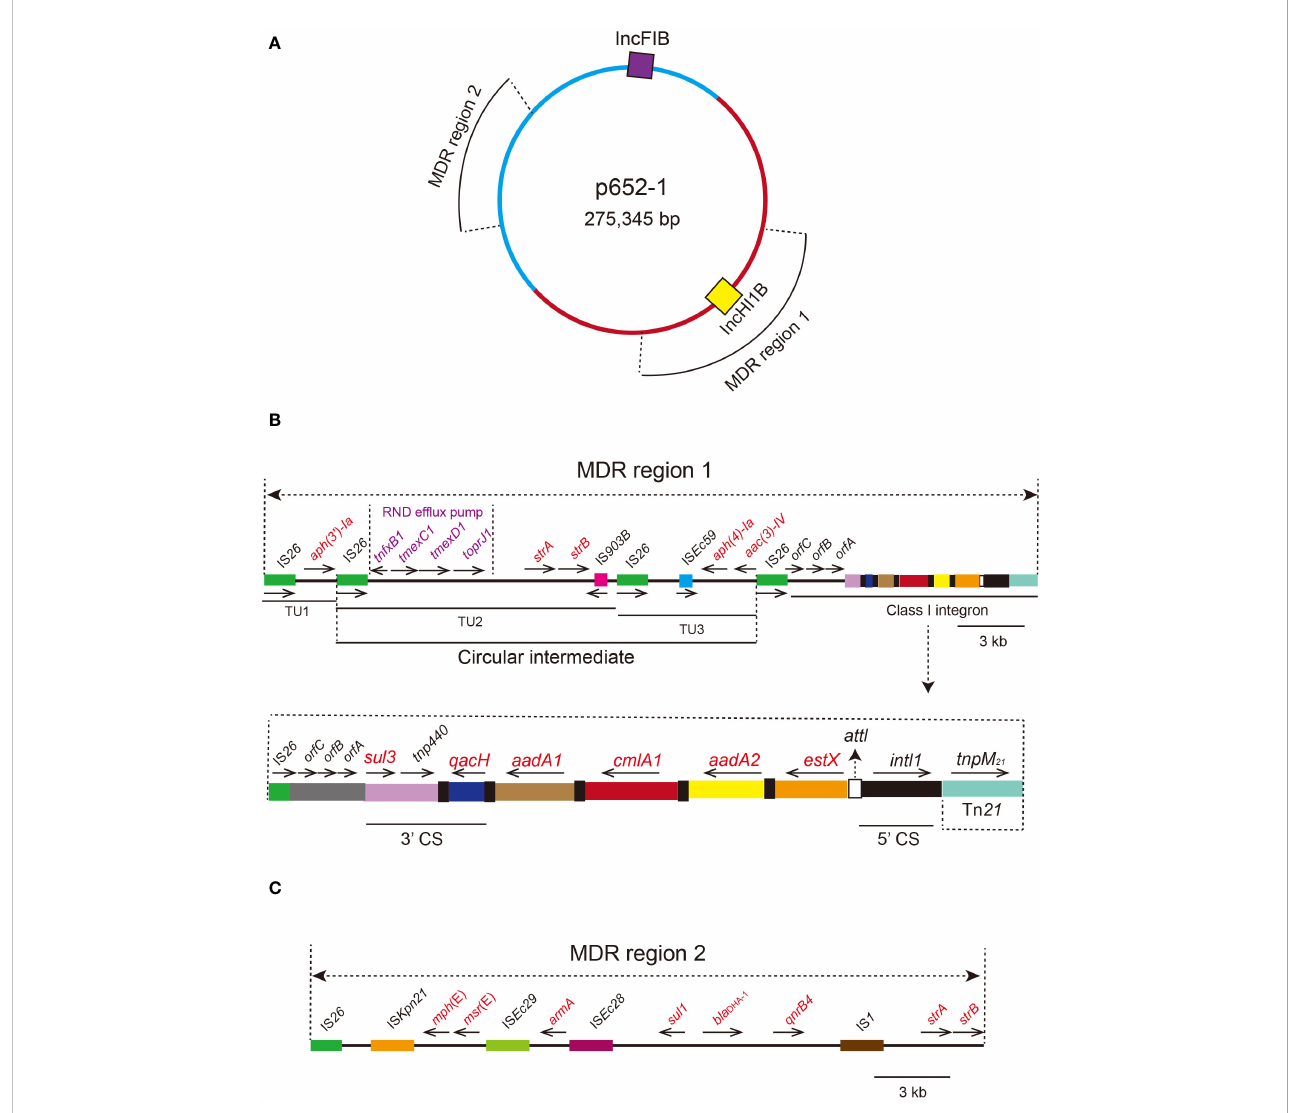
FIGURE 4 Circular proposed map of plasmid p652-1 harboring the tmexCD1-toprJ1 gene cluster and the genetic structure of two multidrug resistance (MDR) regions. (A) Violet- and yellow- fi lled boxes indicate IncFIB and IncHI1B replicons, respectively. Two MDR regions are also shown in different positions. (B) The genetic structure of MDR region 1. IS 26 copies are shown as green fi lled boxes, with black arrows indicating the direction. A circular intermediate form of the tmexCD1-toprJ1 gene cluster is shown. Resistance genes are labeled red in the circular intermediate form. The 5 ’ conserved segment (5 ’ CS) and 3 ’ CS of the class 1 integron are labeled. Various kinds of resistance genes in the integron are also shown as different colors and the names labeled above with the orientation indicated by thin black arrows. (C) The genetic structure of MDR region 2. IS elements are shown as colored boxes. Various kinds of resistance genes are labeled with